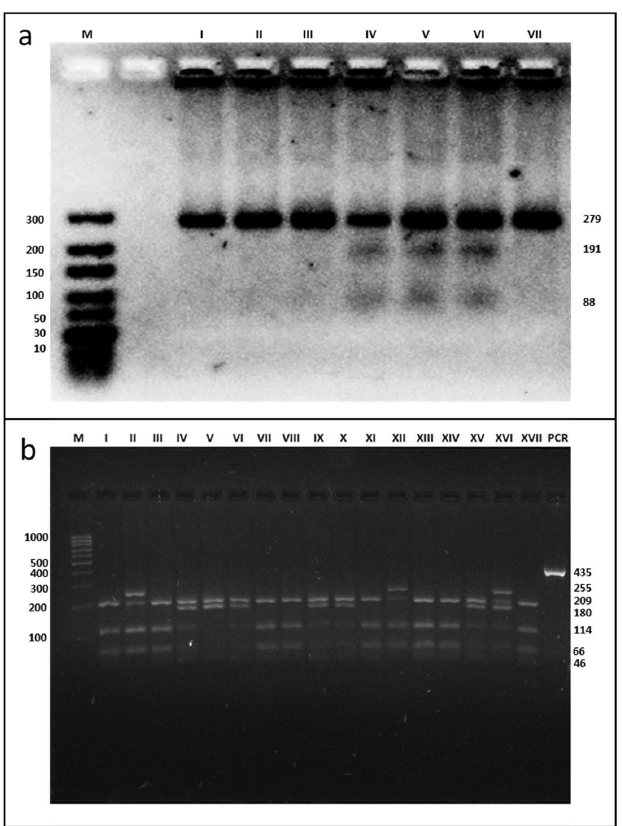
Figure 1. Electrophoresis pattern of PON1 rs662 ( a ) and APOA1 −75 bp and +83 bp ( b